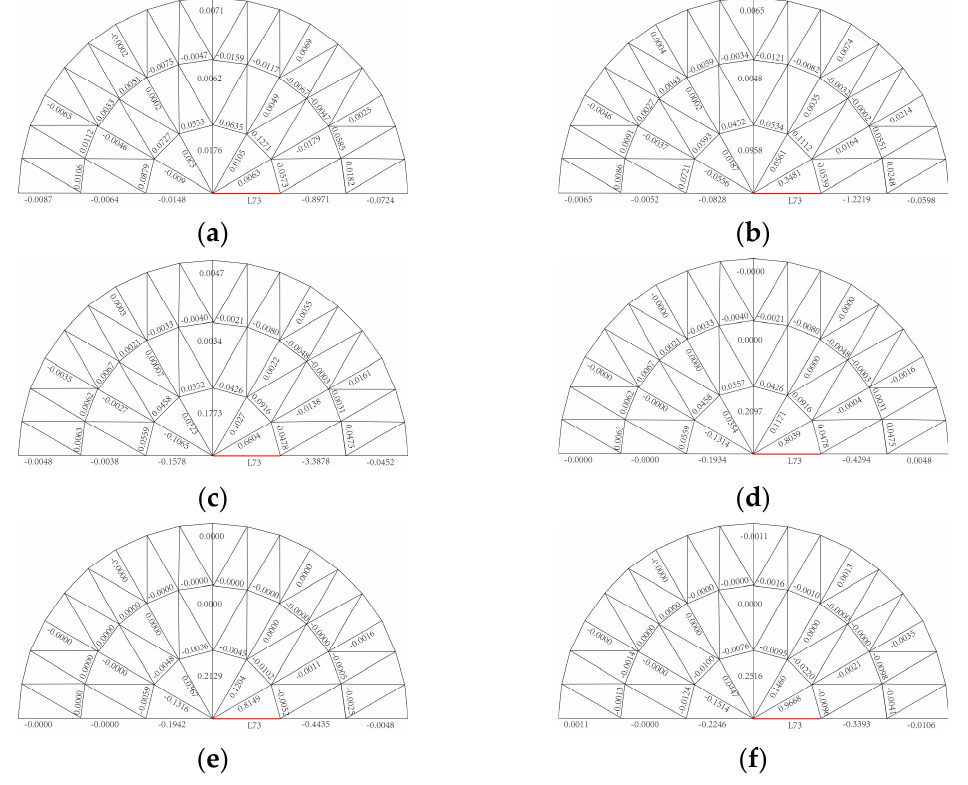
Figure 5. Sensitivity coefficient of L73 main members under fire ( × 10 − 1 ). ( a ) t = 20 ◦ C, ( b ) t = 100 ◦ C, ( c ) t = 200 ◦ C, ( d ) t = 300 ◦ C, ( e ) t = 400 ◦ C, ( f ) t = 500 ◦ C.